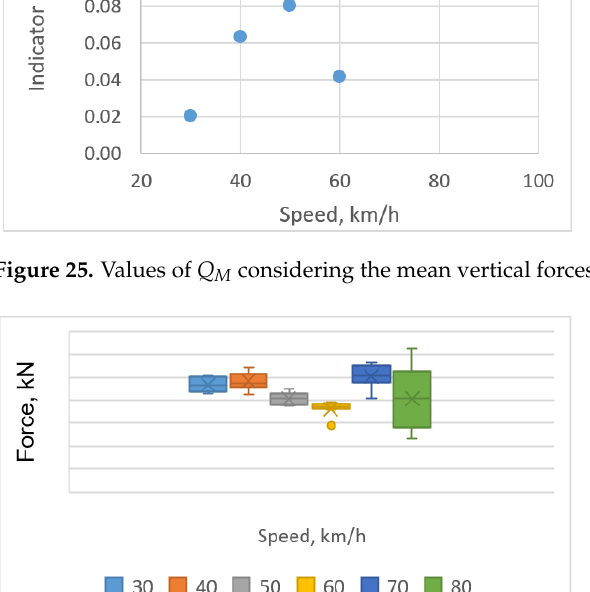
Figure 26. Vertical force mean values of unloaded goods wagon.